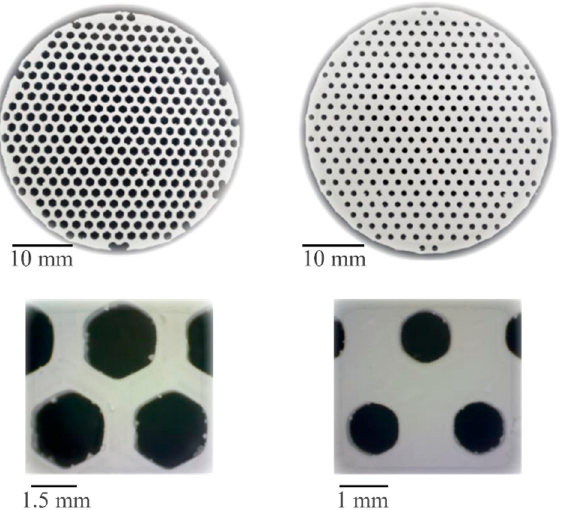
Figure 10. Complex honeycomb “stack” structure with gradient flow channels fabricated by high- speed alumina stereolithography.